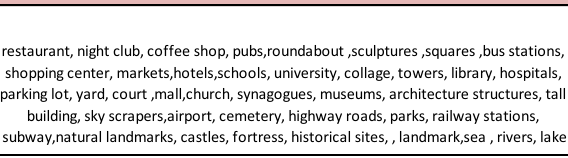
Table 1. List of common landmarks